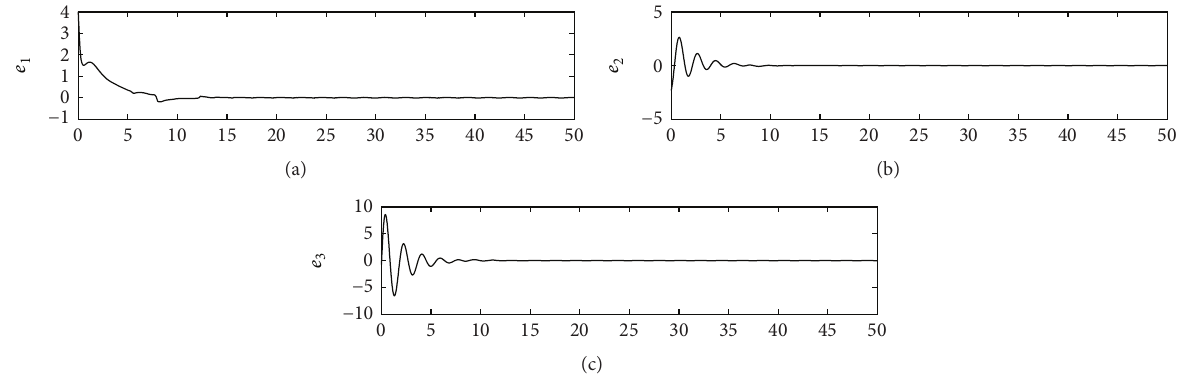
Figure 6: Time evolution of the synchronization errors of CNN system with the gain matrix and nonlinear input.